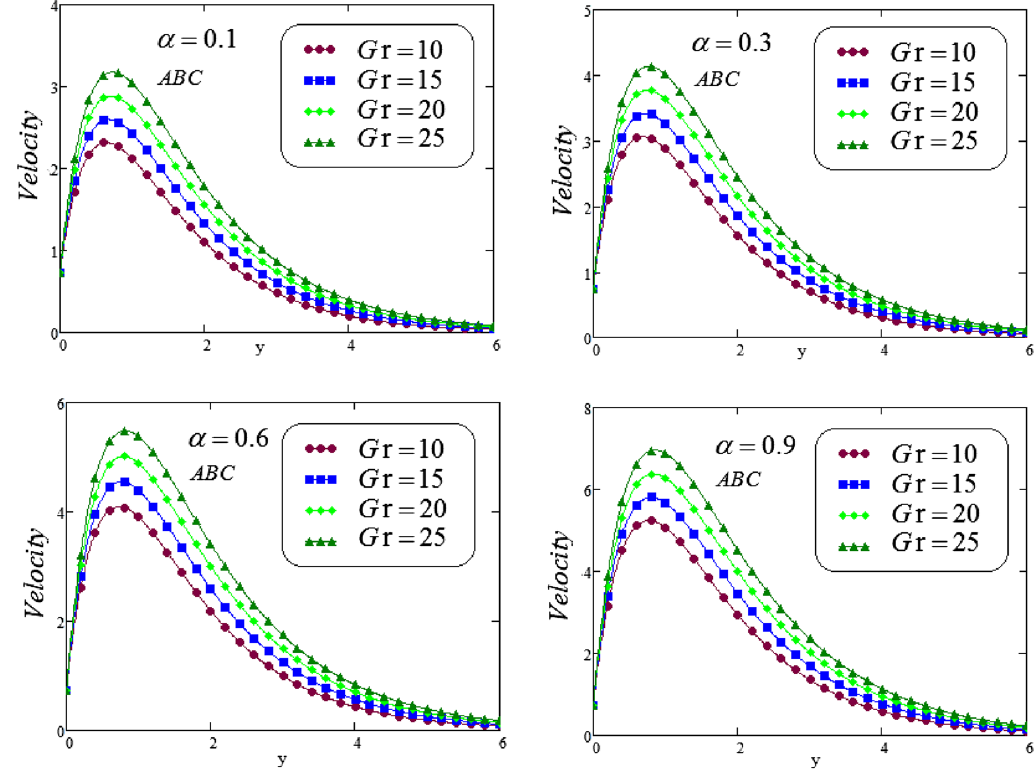
Figure 9. Representation of second grade fluid velocity via ABC for distinct values of Gr .